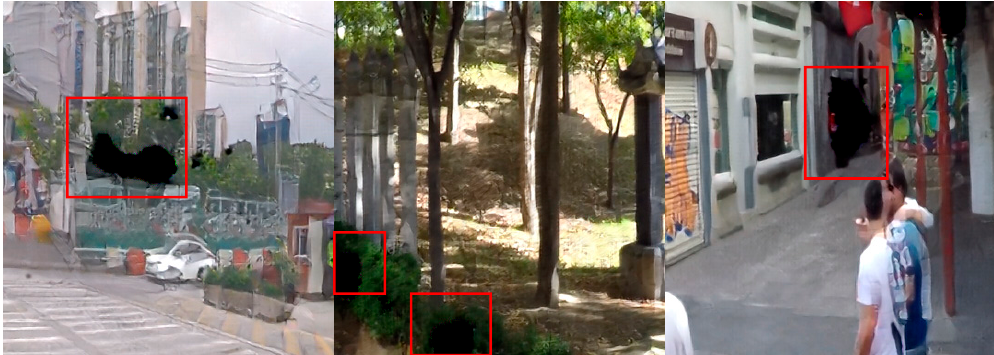
Figure 11. Generated image using low-level feature.